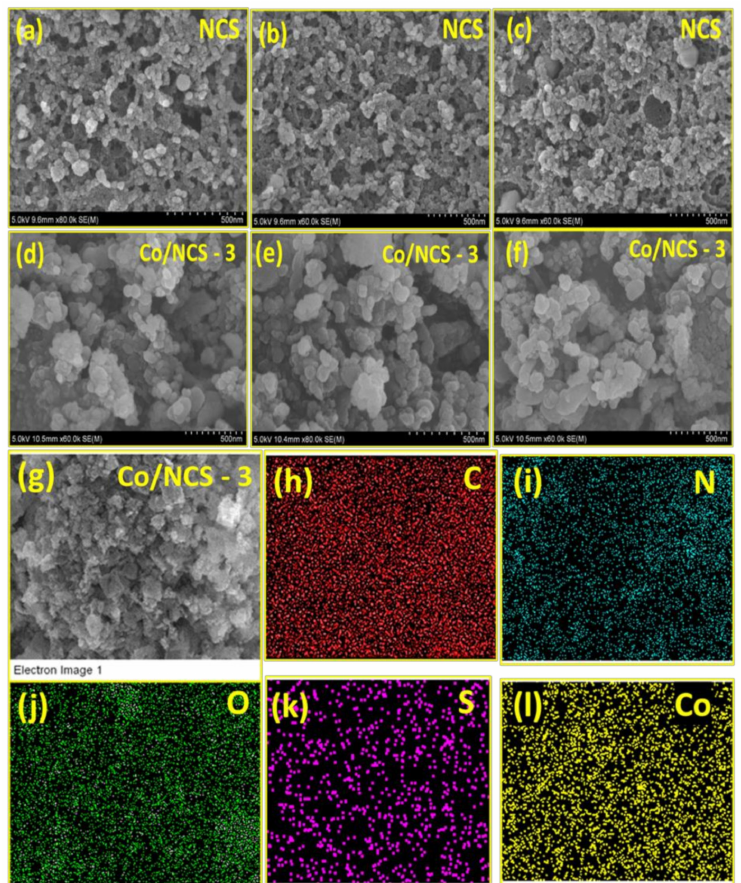
Figure 2. SEM images of NCS ( a – c ), Co/NSC-3 ( d – f ) and SEM elemental mapping for Co/NSC-3 catalyst ( g ) images area ( h ) mapping for C ( i ) N ( j ) O ( k ) S ( l ) Co